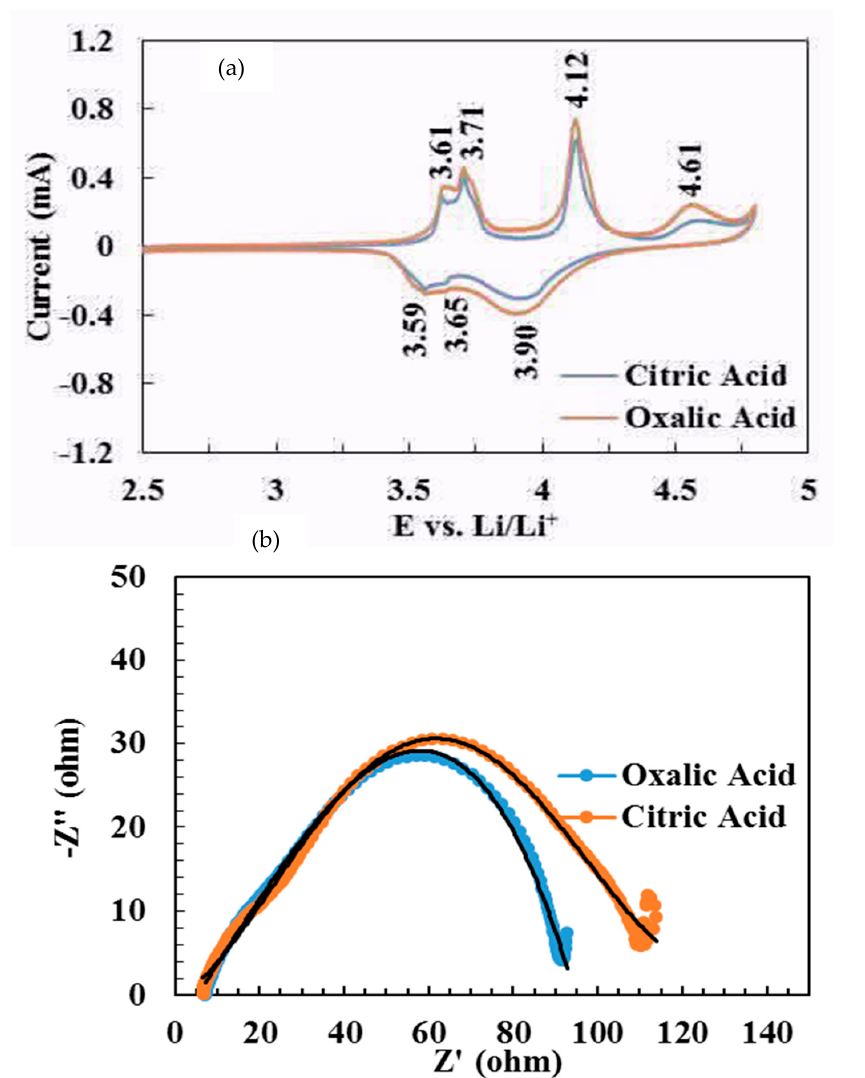
Figure 8. ( a ) Cyclic voltammograms of Li 3 V 2 P 3 O 12 (LVP) prepared using two precursors. Scan rate, 0.1 mVs − 1 , for clarity second cycle are shown, Li metal as counter and reference electrode, and ( b ) Nyquist plots (Z ′ vs. –Z ″ ) of LVP electrodes.